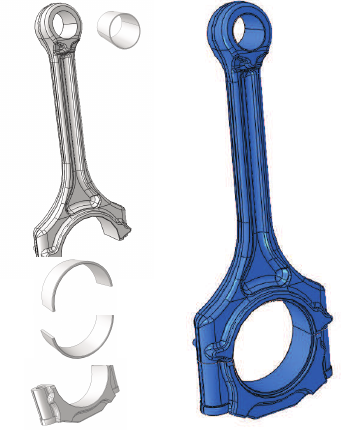
Fig. 1. Elements and assembly of the connecting rod